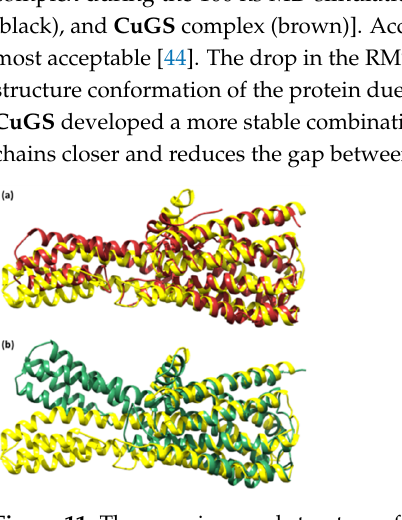
Figure 11. The superimposed structure of ( a ) the unbound serotonin receptor (yellow) and serotonin receptor after simulation (brown) for GpnS and ( b ) the unbound serotonin receptor (yellow) and serotonin receptor after simulation (green) for CuGS .